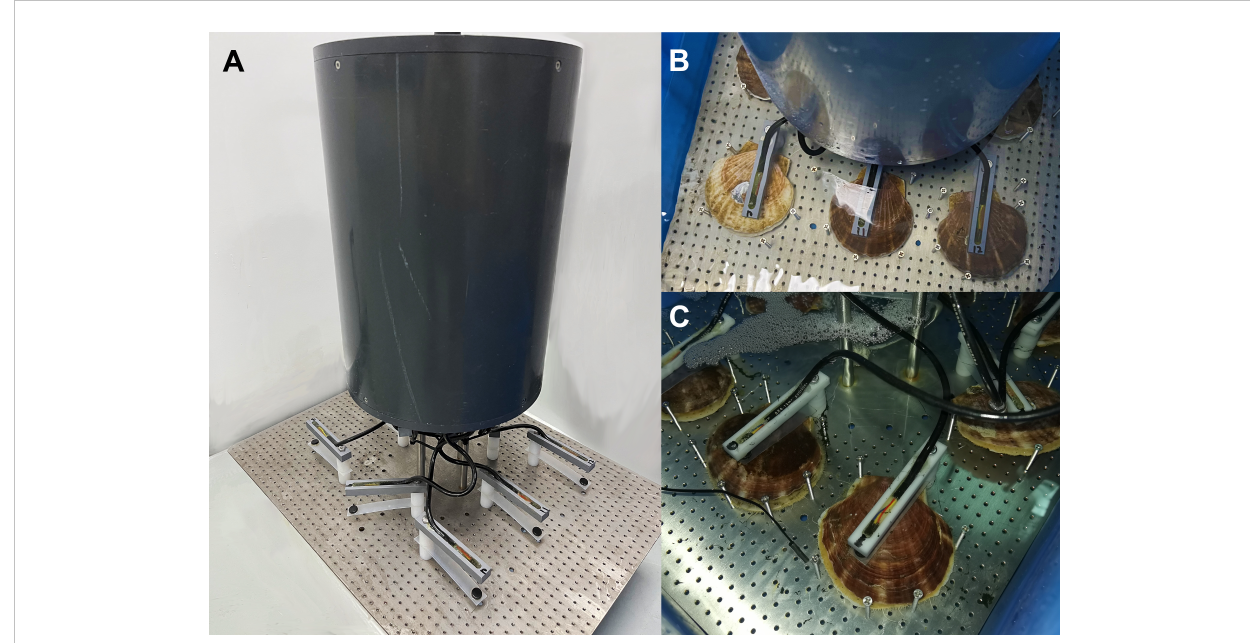
FIGURE 1 Scallop valve movement monitoring device. (A) The overlook view of the monitoring device with eight sensor probes. (B) The top view of the device when monitoring scallops. The activity of each scallop was limited to the area enclosed by speci fi c fences. (C) The scallops lay undisturbed during the